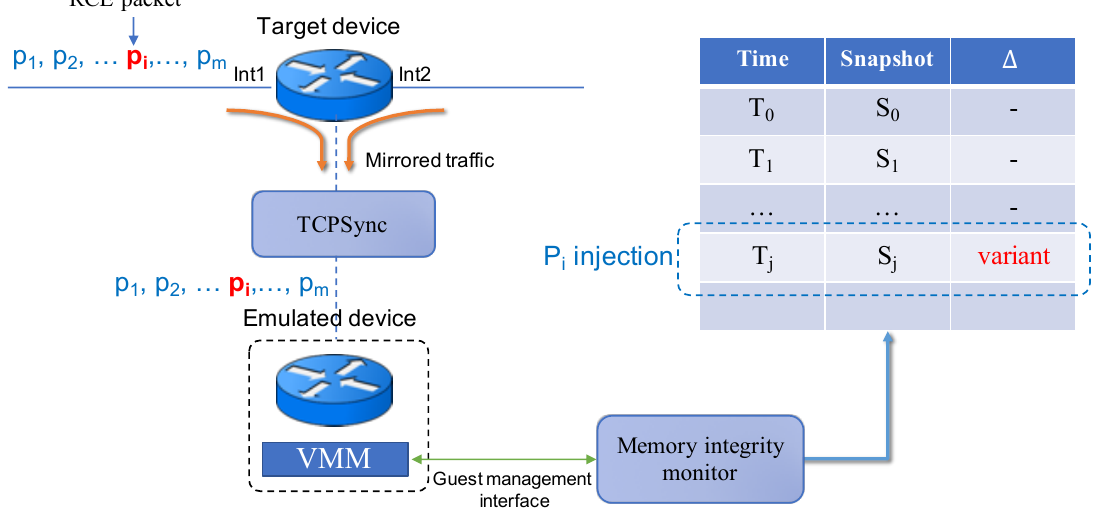
Figure 2. Example of a remote code attack